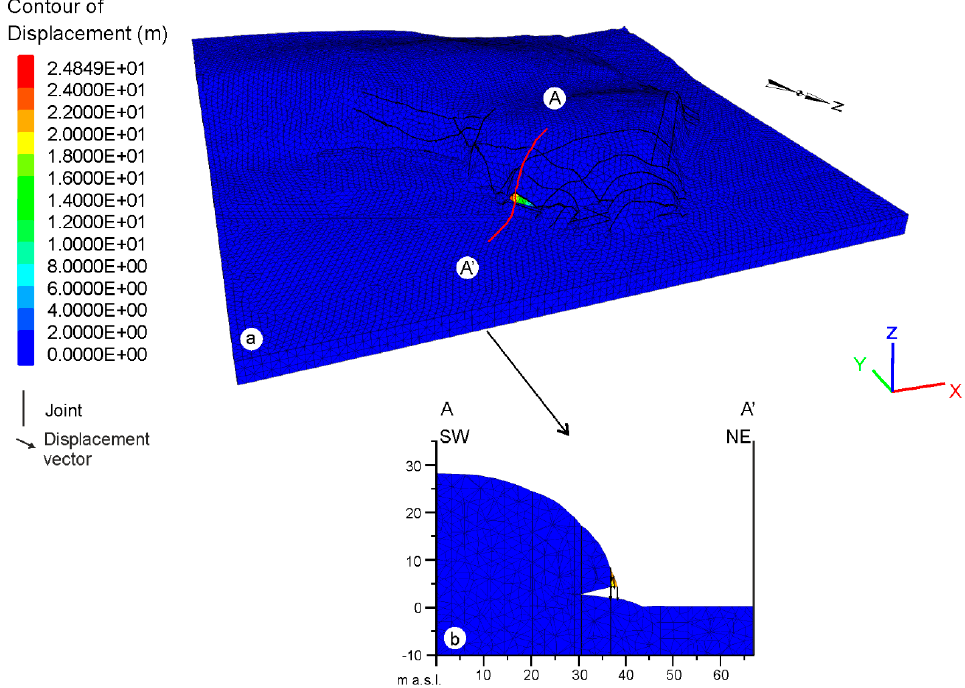
Figure 16. ( a ) The displacement contours and vectors of the pre-landslide model of the Punta Aderci cliff; and ( b ) the A-A’ section. Geosciences 2018 , 8 , x FOR PEER REVIEW